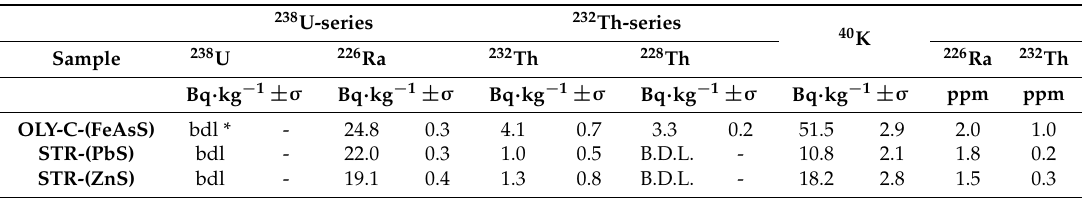
Table 5. Activity concentrations of 238 U, 226 Ra, 232 Th, 228 Th, and 40 K (Bq · kg − 1 ), along with the respective standard errors ( ± σ ). 238 U-series 232 Th-series